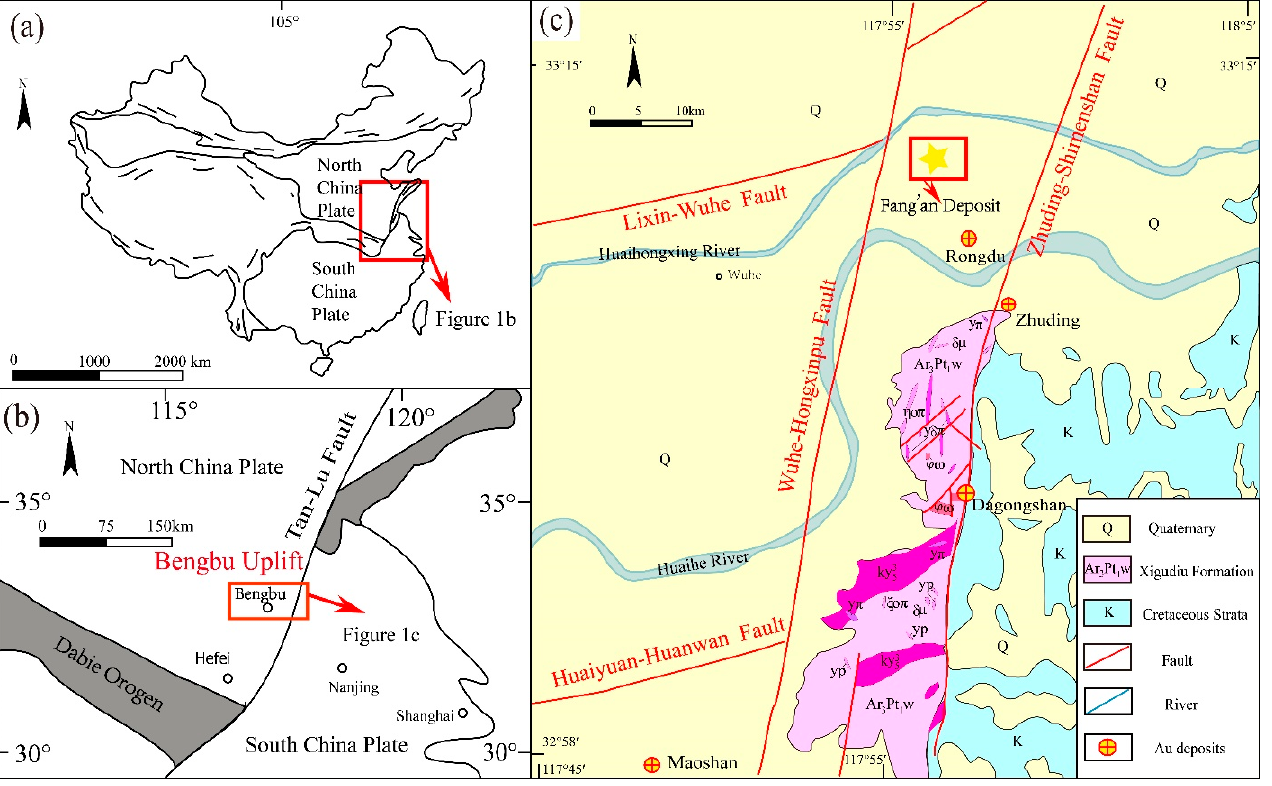
Figure 1. ( a ) Location of Fig.1b in China; ( b ) tectonic location of Bengbu uplift in eastern China; ( c ) geological map of Fang’an gold deposit, modified after [15].